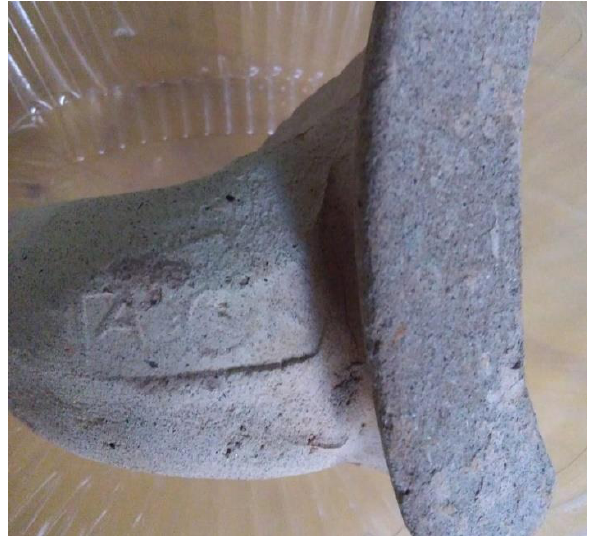
Figure 1 : ΓΑΡ crown N stamp found on an MGS IV amphora fragment in the 2019 excavation campaign of the Piazza Nicola Amore area,